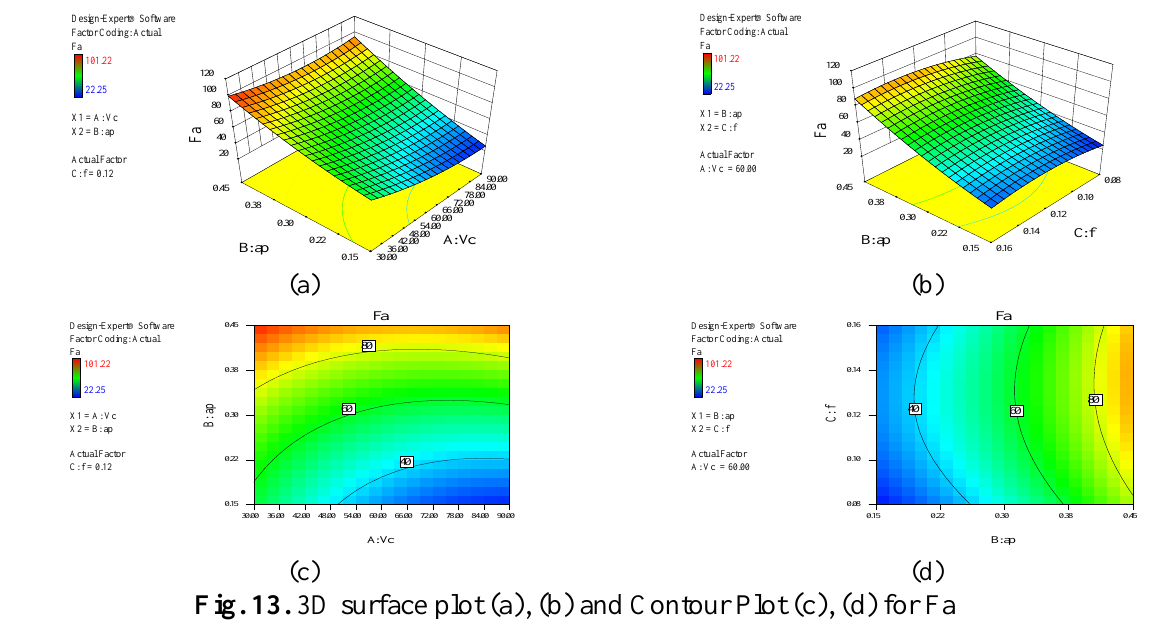
Fig. 13. 3D surface plot (a), (b) and Contour Plot (c), (d) for